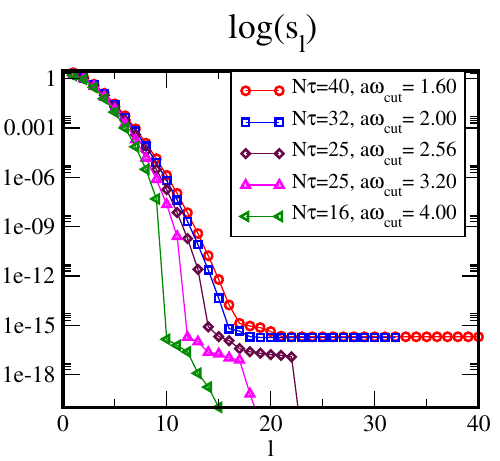
Figure 16 . N (cid:28) dependence of the singular values for the kernel matrix. Here, we (cid:12)x N (cid:28) a! cut = 64 : 0 di(cid:11)erent between the input and the outputs. It suggests that the input smeared correla- tion function can not be described by the kernel given by the hyperbolic cosine function in eq.